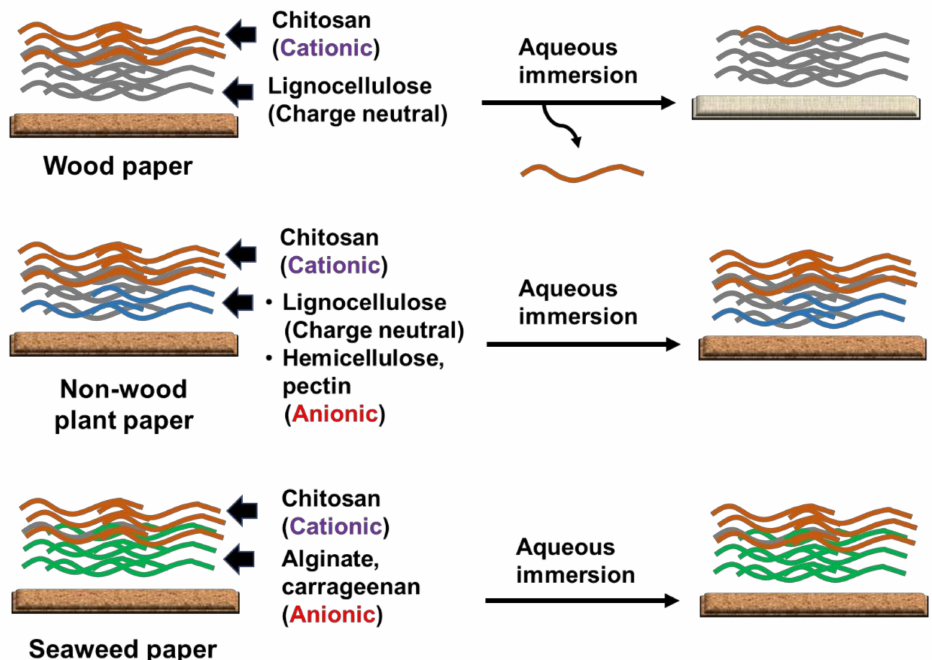
Figure 2. Schematic illustration of wood, non-wood plant and seaweed papers coated with chitosan with different binding affinities. Non-wood plant and seaweed papers having anionic components demonstrate higher binding affinities than wood paper, which is charge